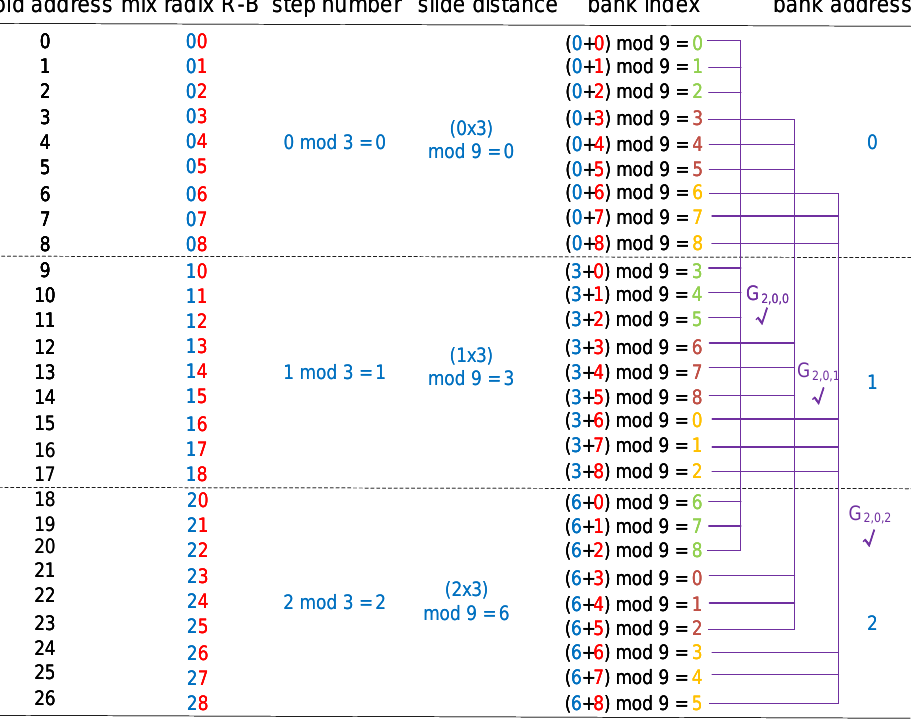
Figure 15: The detailed memory mapping scheme for 27-point radix-3 NTT with d =